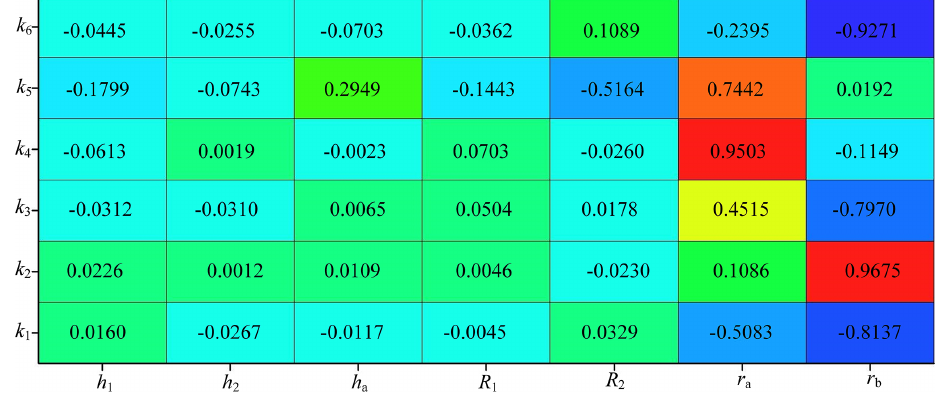
Figure 6. Correlation matrix of the design variables and objective functions. Table 4. Optimal Pareto solution set for a multi-objective optimization.